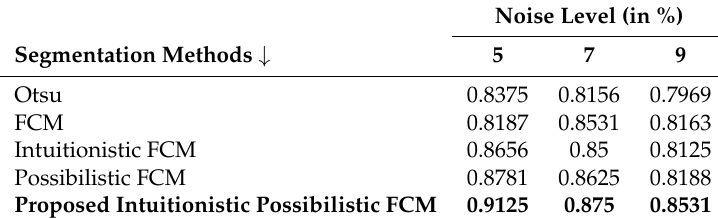
Table 4. Average segmentation accuracy with different noise